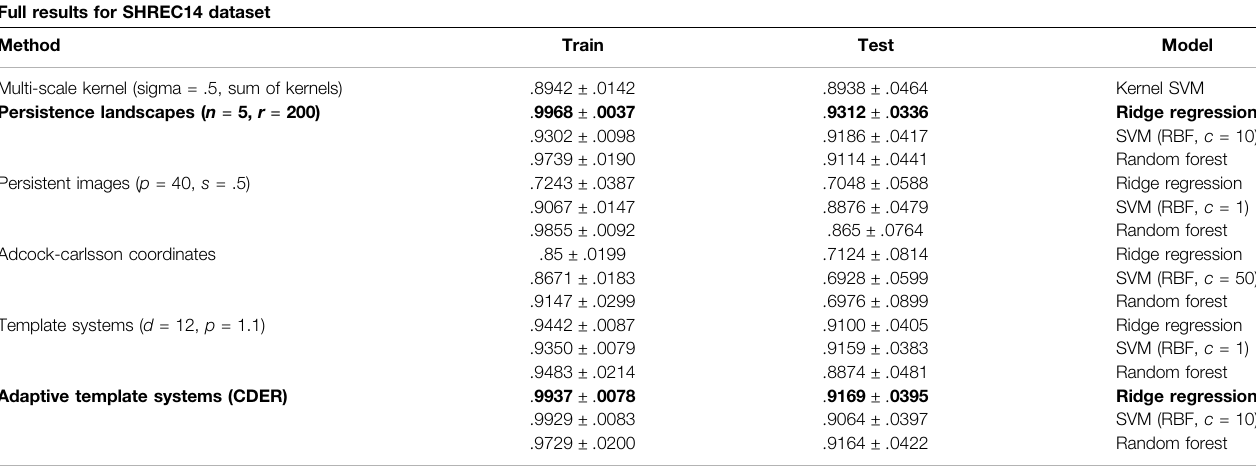
TABLE 1 | Results from the Shrec14 Dataset using the average model classi fi cation accuracy ± standard deviation over 100 trials. Full results for SHREC14 dataset